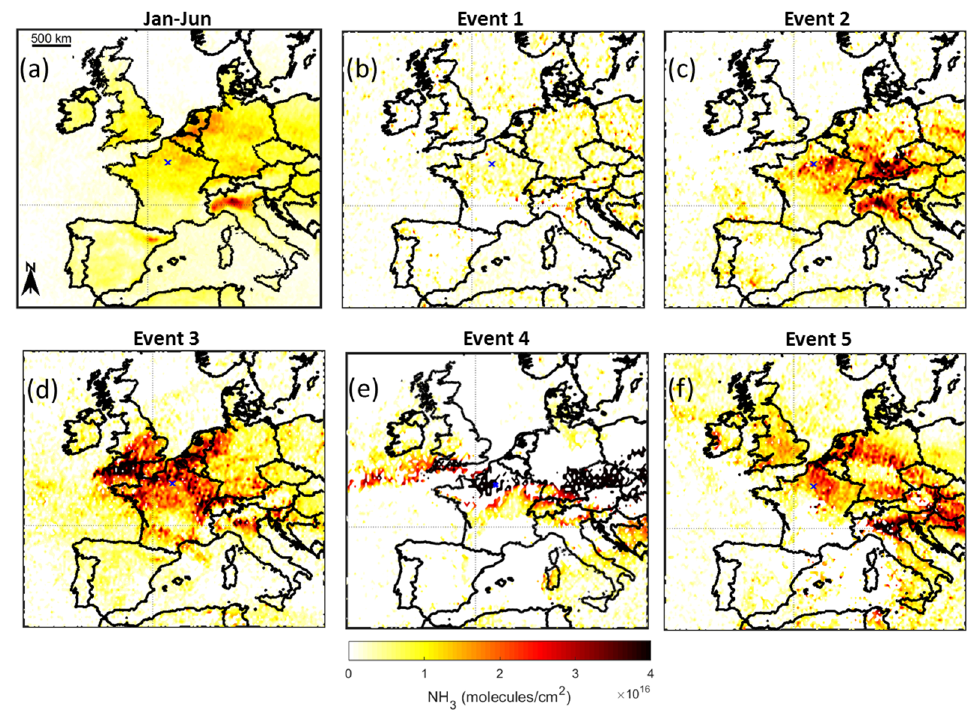
Figure 3. IASI NH 3 total column (molecules/cm 2 ) average distributions over Paris (blue cross) for ( a ) January to June 2020, and ( b – f ) the five periods investigated .